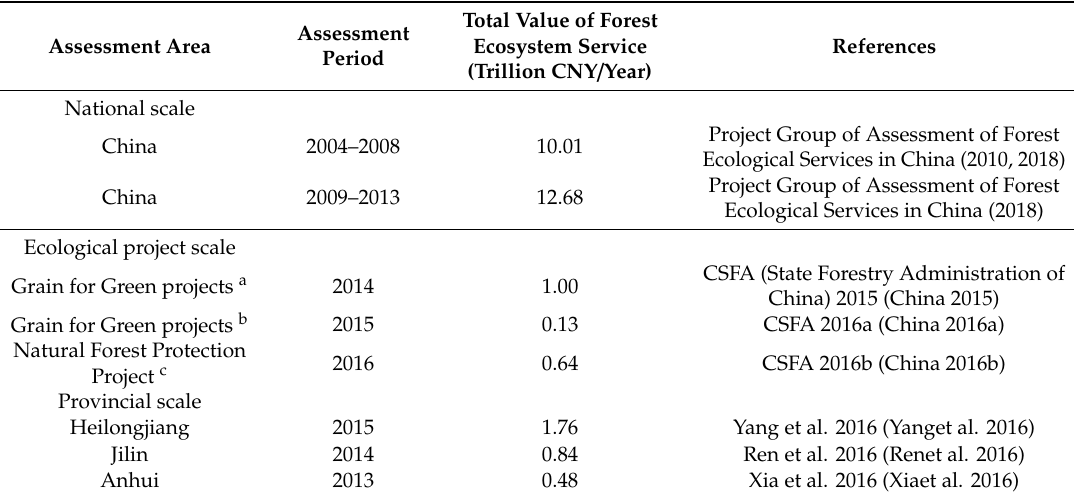
Table 3. Assessment of forest ecosystem services based on the